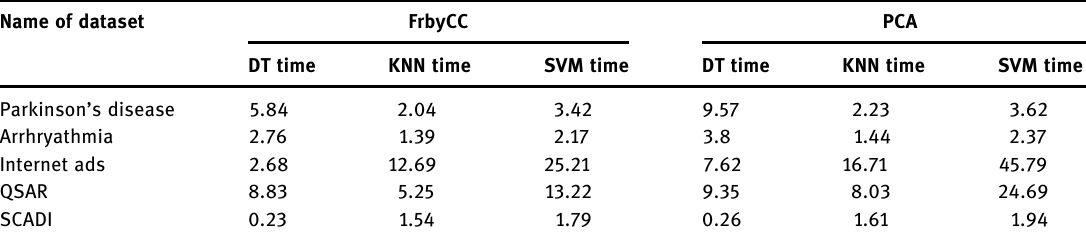
Table 7: Execution time comparison of FrbyCC and PCA method with DT, KNN, and SVM classi fi er ( time measured in seconds ) Name of